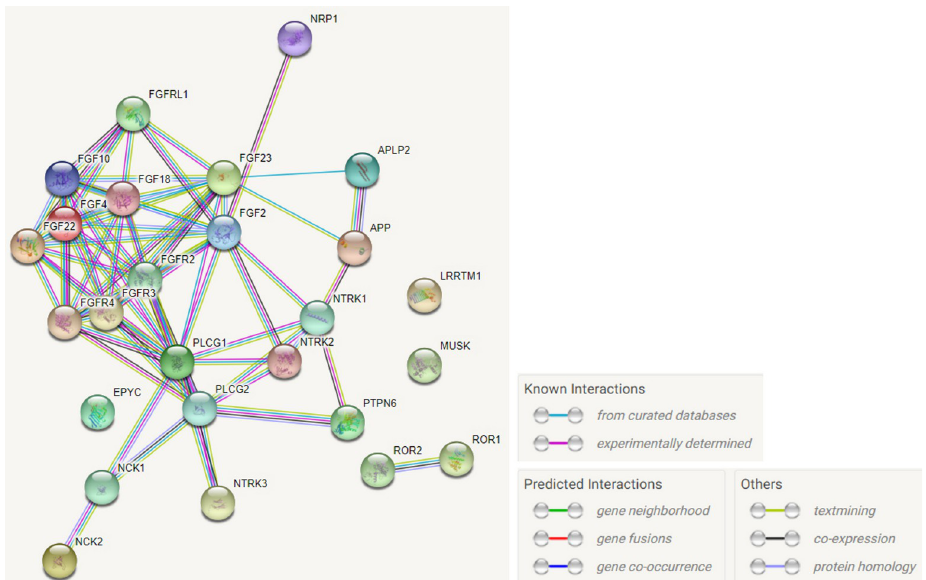
Fig 1. Protein-protein interactions with high confidence score (confidence score > 0.7) for FGFRL1 . Proteins in the interaction network are represented as nodes; the line color represents the type of interaction, including known interaction, predicted interaction and other types. These interactions include physical (direct) and functional (indirect) types according to computational predictions and experimental repositories.